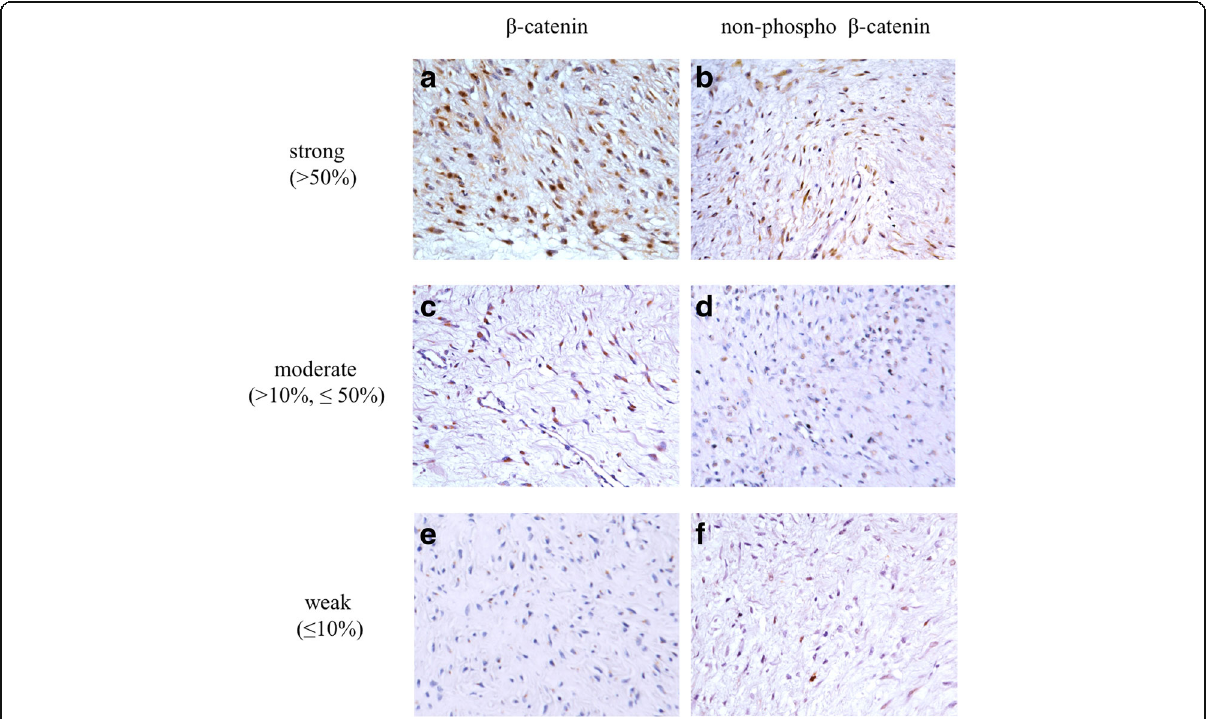
Fig. 2 Nuclear staining for β -catenin and non-phospho β -catenin. Representative images were shown with staining for β -catenin ( a , c , e ) and non-phospho β -catenin ( b , d , f ). a and b ; strong, c and d ; moderate, e and f ; weak. (counterstained with hematoxylin; original magnification, ×200)